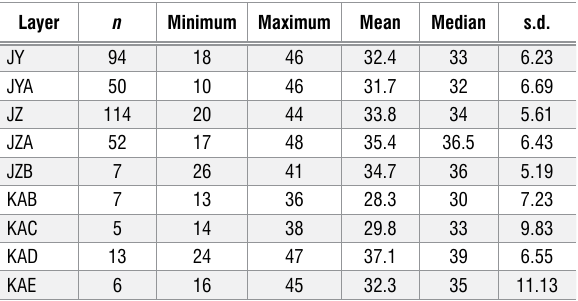
Opercula lengths range between 10 mm and 48 mm through the sequence.